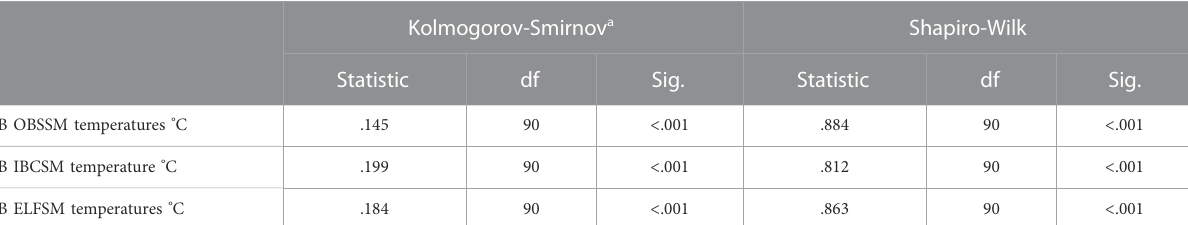
TABLE 7 Normality test of B OBSSM, B IBCSM, and B ELFSM.